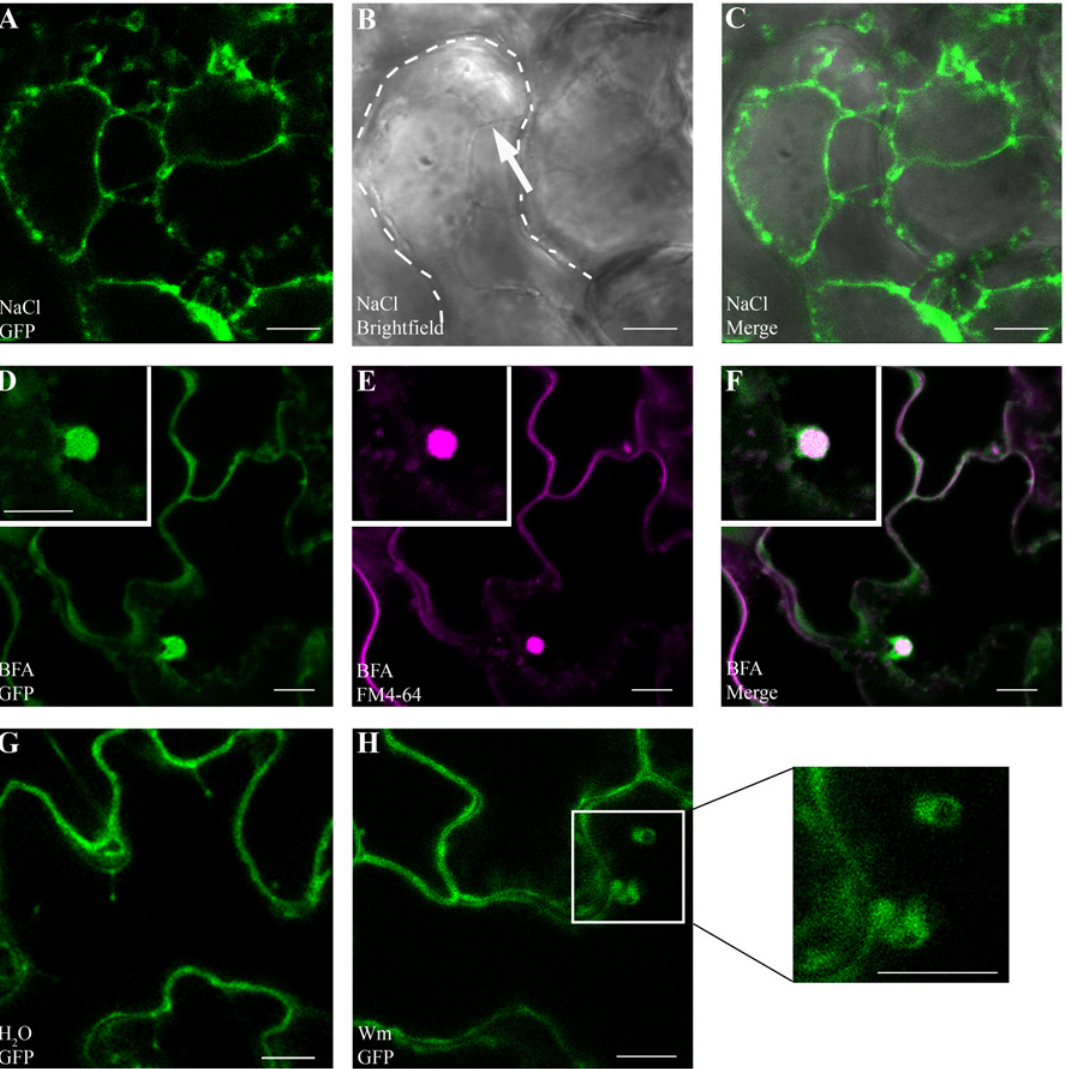
Fig 6. GAPC1-GFP localizes to intracellular membranes and localization is altered by endosomal trafficking inhibitors. Confocal micrographs of the gapc1 KO complemented with npro :: GAPC1-GFP (line 3 – 4) show optical sections of three-week-old leaves. (A- C) Plasmolysis using 1 M NaCl demonstrates that GAPC1-GFP is localized to Hechtian strands, providing evidence of plasma membrane localization. Arrow indicates Hechtian strand, and dotted line marks the cell boundary. (D-F) Leaves treated for 1.5 h with 30 μ M BFA and co-stained with 1 μ M FM4-64 highlight localization of GAPC1-GFP in BFA bodies. (G-H) Leaves treated with 33 μ M Wortmannin (Wm) have an increased size of GAPC1-GFP fluorescent puncta relative to water treatment. Inset shows enlarged representative fluorescent puncta. Bar = 10 μ